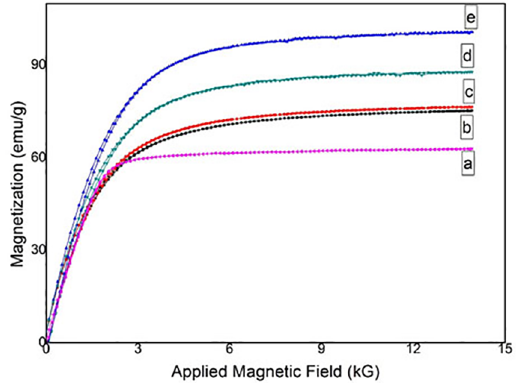
Figure 7. Magnetization curve as a function of the magnetic field applied in duplex stain-less steel samples under different conditions: (a) as received; (b) after 5 hours of milling without carbide; (c) adding 3% NbC after 5 hours of milling (d) addition of 3% NbC after 20 hours of milling; (e) after 20 hours of milling without carbide.